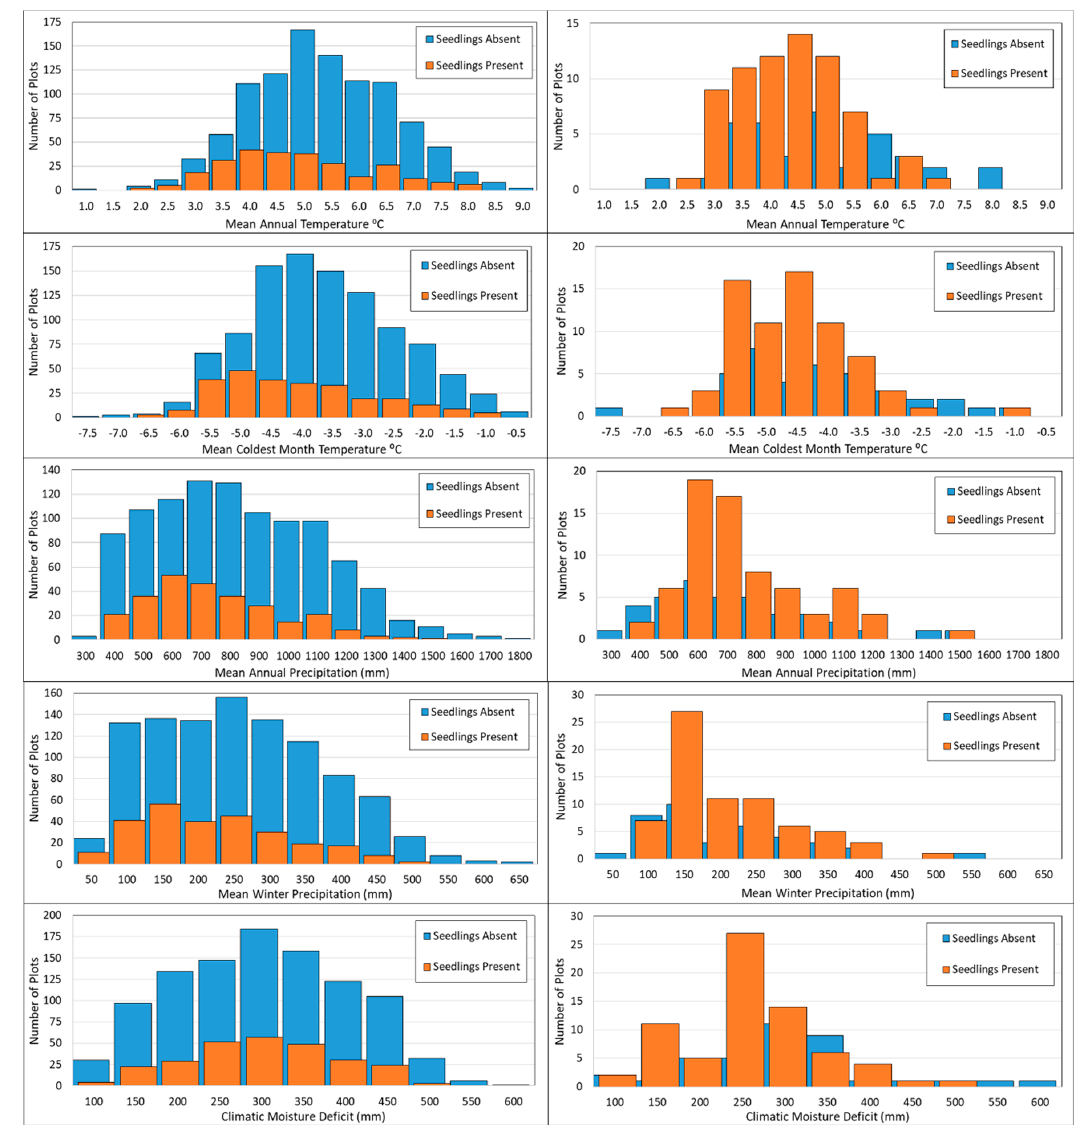
Figure 5. Histograms of western larch seedling presence/absence for all plots (left column) and for only plots with recent fire disturbance (right column) relative to selected climate variables.